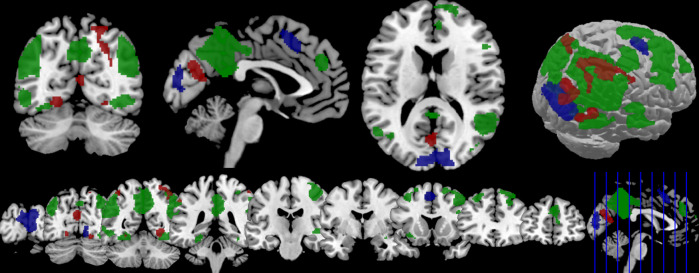
Second-order fMRI results. Significant activation in the contrasts Ketamine>Placebo (red), Report>Follow (blue) and Follow>Report (green) at significance level P < 0.001 (uncorrected).